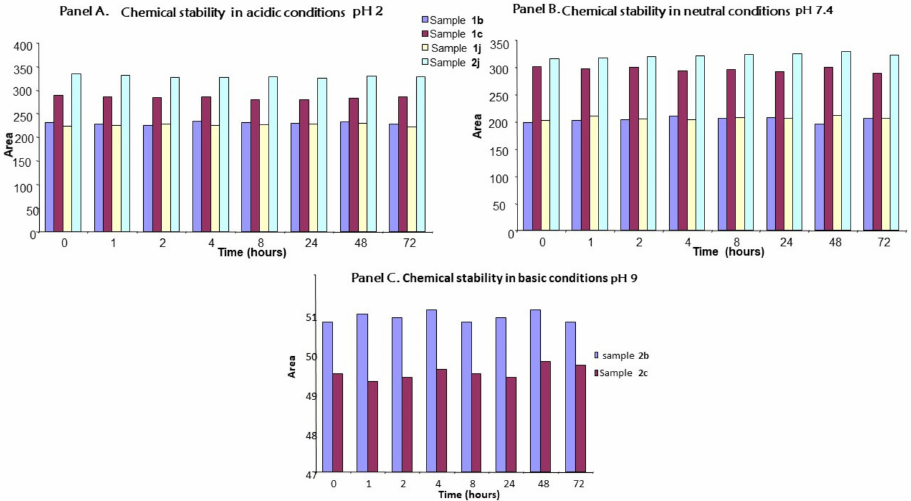
Figure 11. Area under the curves for compounds 1b – c , 2b – c , 1j , and 2j , in acidic (panel A ), neutral (panel B ), and basic (panel C )